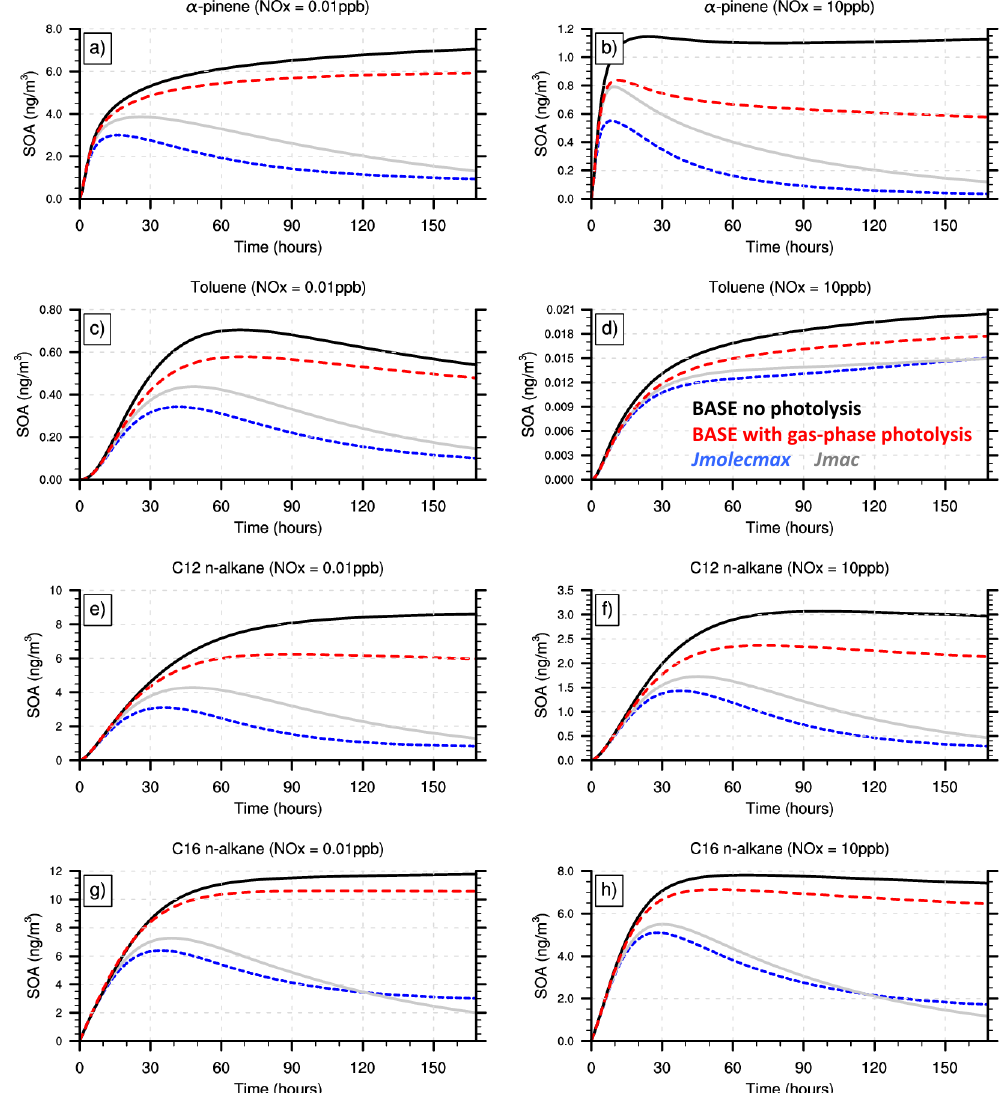
Figure 5. Predicted effect of photolysis on SOA concentrations from the oxidation of 1ppt of α -pinene, toluene, and C 12 and C 16 n -alkanes at low (0.01ppb) and high (10ppb) NO x levels. Plots compare GECKO-A simulations for the BASE no-photolysis run (black), BASE run with gas-phase photolysis (red), J molecmax (blue) and J mac (gray). To derive equivalent atmospheric summertime exposure of our experiments, times should be multiplied by a factor of 2 (Table 1). See Table 2 for the description of various